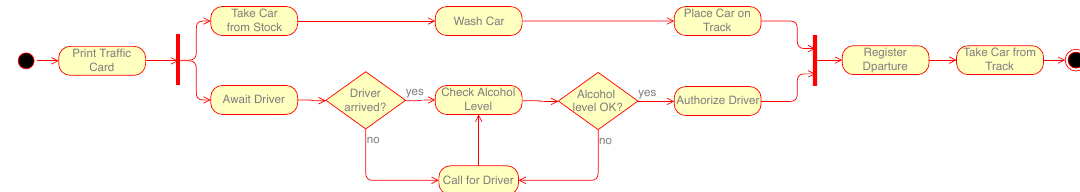
Figure 8. An example of an equivalent model to the spreadsheet-based process description presented in Table 18.